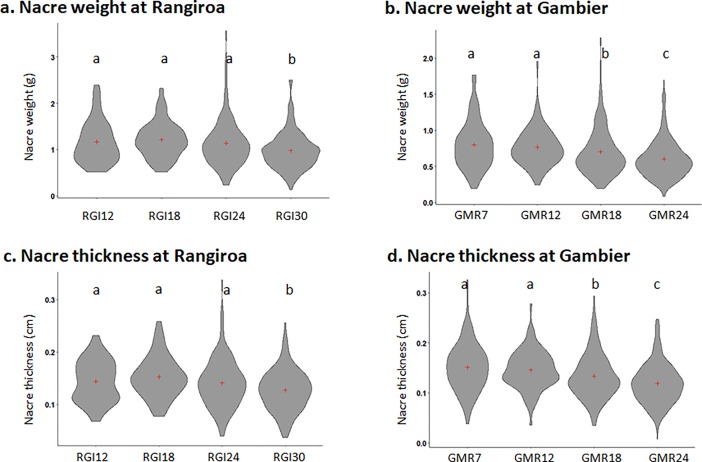
Pearl size harvested for the two sites across four age classes.Pearl nacre weight pearls in Rangiroa (a) and Gambier (b) and mean pearl nacre thickness in Rangiroa (c) and Gambier (d) measured across four age classes. “+” Cross represent the mean in the violin plot. Letter indicates significant difference between the age group (p < 0.05). Datas available on S2 Appendix.